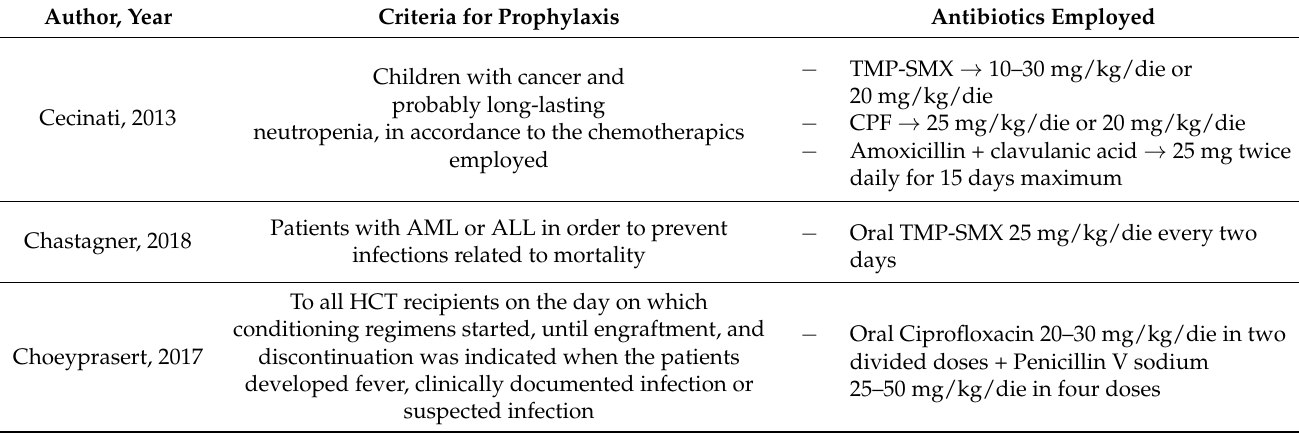
Table 1. Main studies regarding antibiotic administration in children with